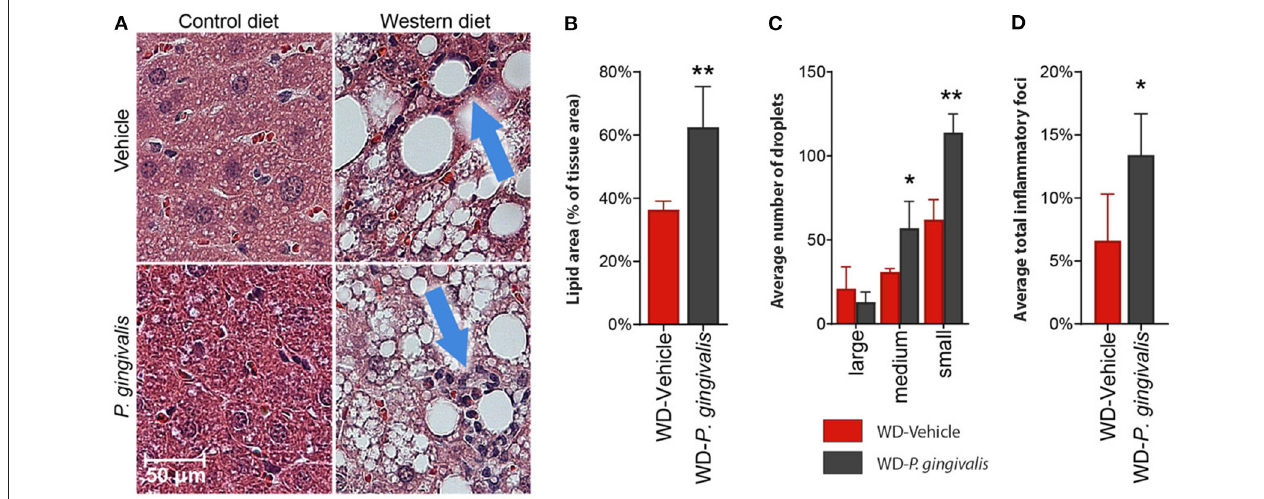
FIGURE 1 | P. gingivalis infection exacerbates hepatic steatosis in mice fed a WD. (A) H&E stained, paraffin-embedded liver sections from control diet- or Western diet-fed mice that were either infected with P. gingivalis or treated with vehicle. Blue arrows indicate inflammatory foci. (B) Lipids quantified as lipid area as percent of total tissue area. (C) Lipid droplets binned by area. Red = vehicle-treated mice fed a WD, black = P. gingivalis -infected mice fed a WD. (D) Inflammatory foci quantified as foci per view. CD, control diet; WD, Western diet. Lipid droplets were only measured in the WD groups because there were so few in CD-fed mice. * p < 0.05, ** p < 0.01 P. gingivalis -infected vs. vehicle-treated mice fed a WD. n =